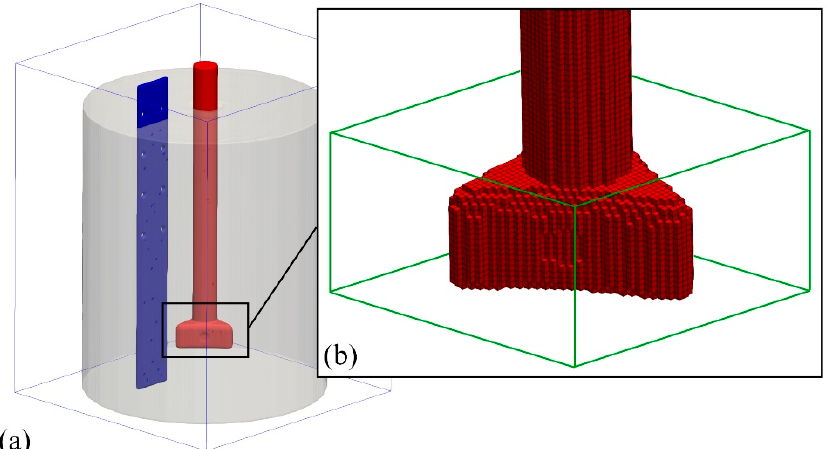
Figure 7. Structured equidistant mesh used in numerical calculations: ( a ) mesh with smoothed, surface cells (the so-called FAVOR method) used in Flow-3D; ( b ) visualization of the applied mesh resolution.